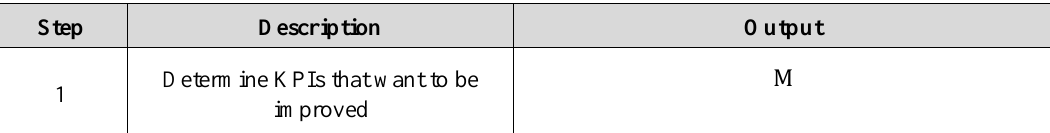
Table 6. Step 1/5 of detecting collaboration partner